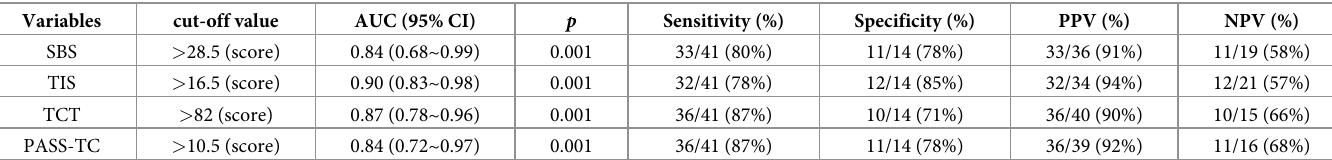
Table 3. The SBS, TIS, TCT, PASS-TC, cut-off value, sensitivity, specificity, positive/negative predictive values for mobility level in participants.